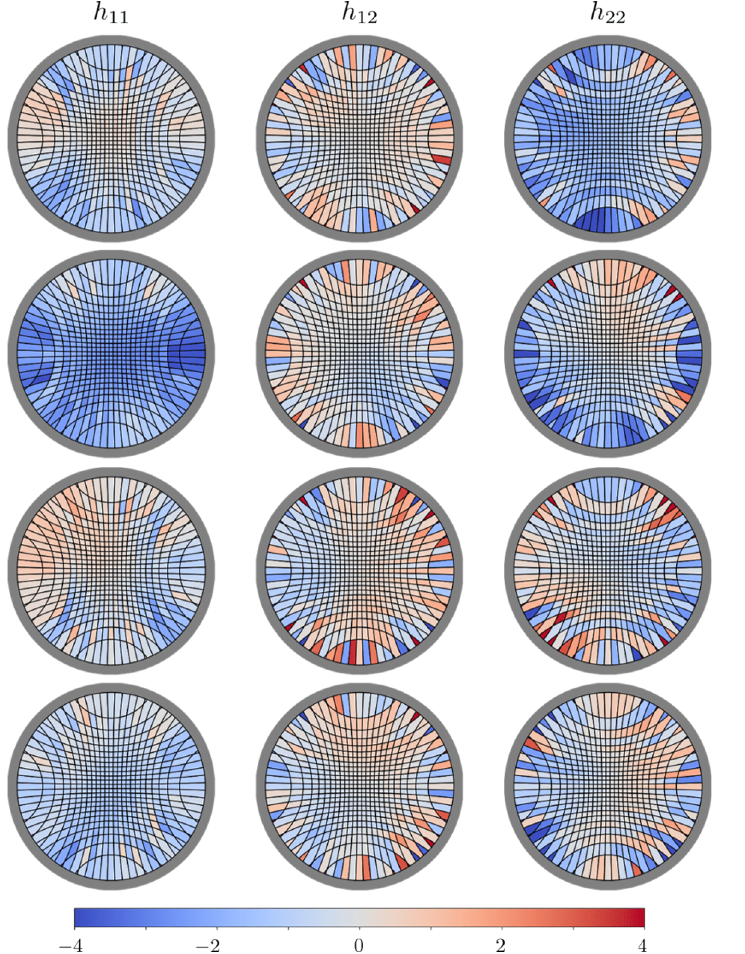
Figure 12. A bulk best-fit reconstruction of a state generated with random disorder. Each row is a reconstruction of a particular instance with random disorder. The boundary relative errors vary across a wide range of values, but typically 0 . 05 . E bdy . 1 (see figure 13a).